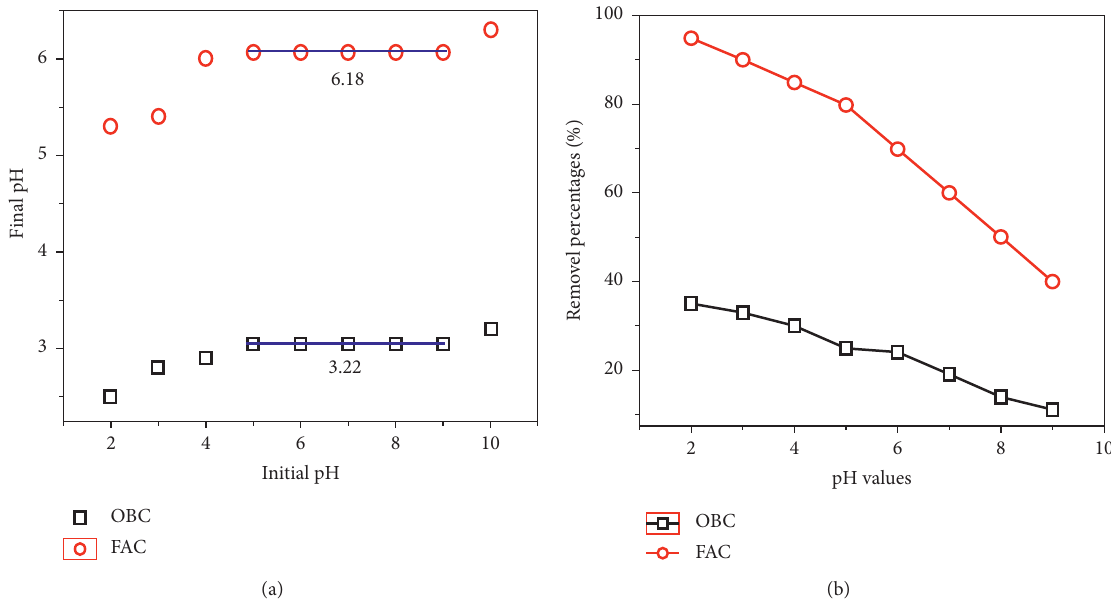
Figure 3: (a) Plot of final pH vs. initial pH, and (b) influences of pH on As(V) adsorption using OBC and FAC ( m adsorbents � 50mg; V As(V) solution � 50mL; time � 30min; C o of As(V) � of